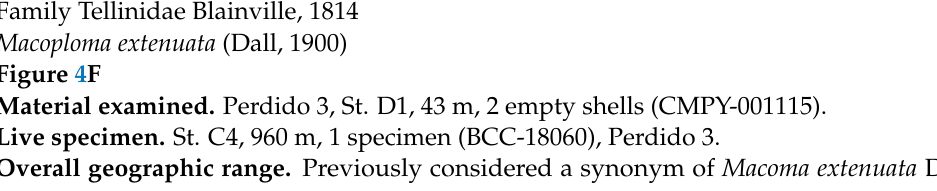
Material examined. Perdido 3, St. B2, 48.8 m, 1 empty shell (CMPY-001128). Family Veneridae Rafinesque, 1815 Chione sp. Material examined. Perdido 4, St. C5, 1267 m, 1 empty shell (CMPY-002363).